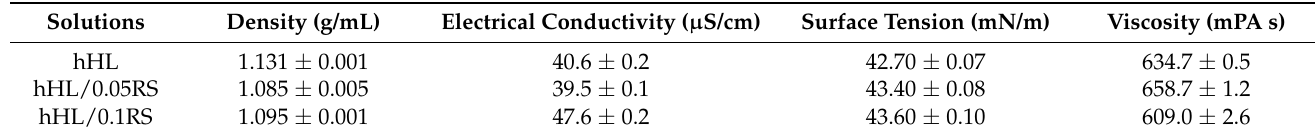
Table 1. Physical characteristics of solutions used in EHDA